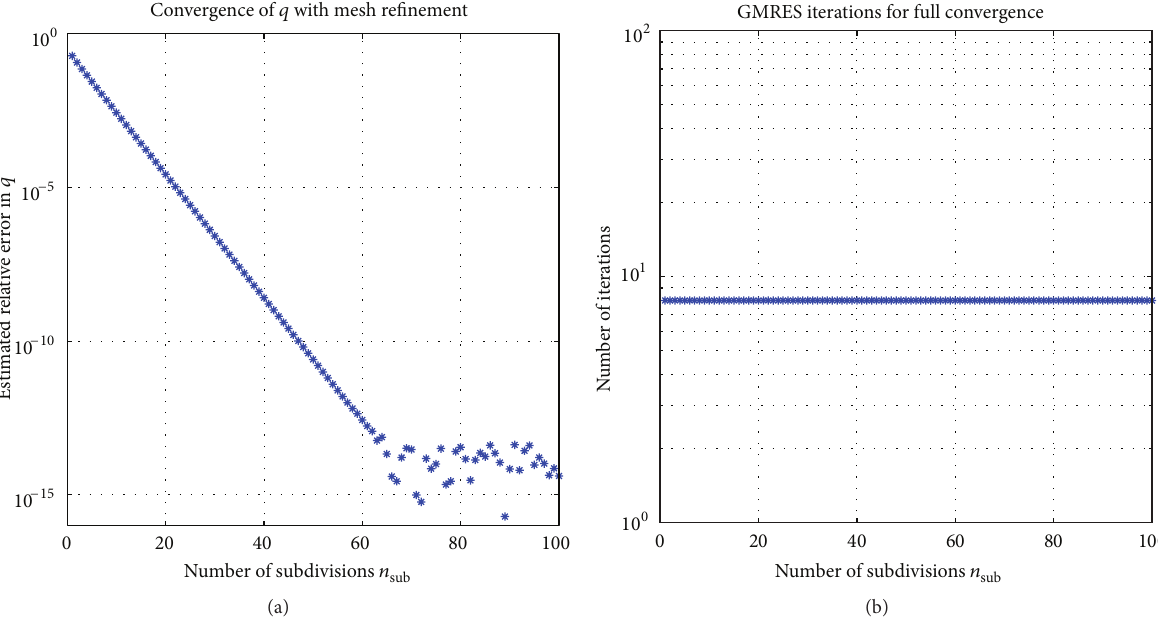
= 160 unknowns in the main p